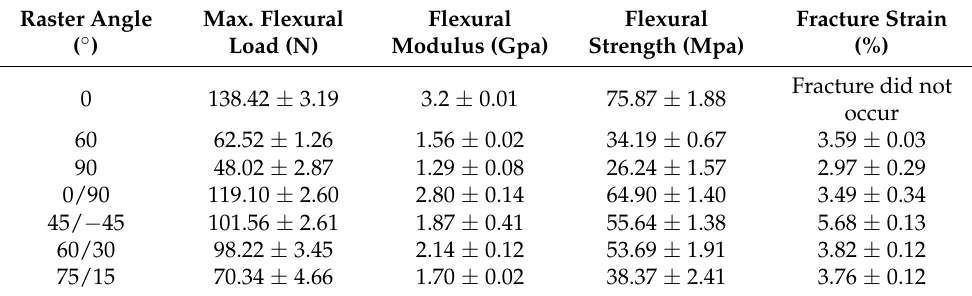
Table 2. Experimental results for flexural properties at different raster angles. Raster